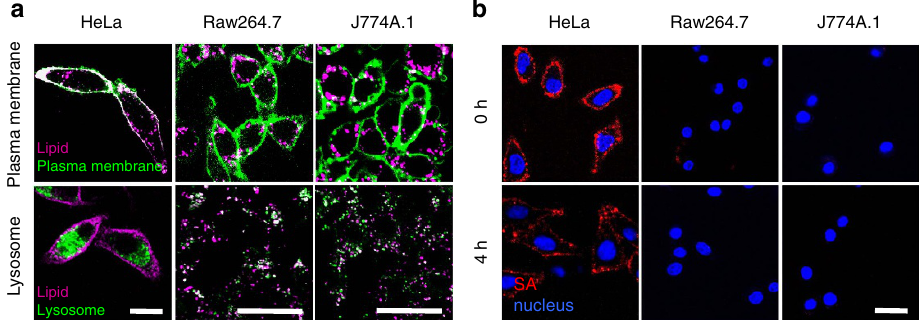
Figure 3 | Tumour cell membrane-specific delivery of SR-lipids. ( a ) Confocal fluorescent microscopic images of tumour cells (HeLa) and macrophages (Raw264.7 and J774A.1) after FL-mediated delivery of fluorophore-lipids (magenta). Cells were treated with fluorophore-FLs for 1h and then imaged. Plasma membranes and lysosomes were stained with CellMask and LysoTracker (green), respectively. ( b ) Confocal fluorescent microscopic images of tumour cells (HeLa) and macrophages (Raw264.7 and J774A.1) treated with fluorophore-SA (red) 0h (immediately) or 4h after FL-mediated biotin-lipid delivery. Nuclei were stained with Hoechst (blue). Scale bar represents 20